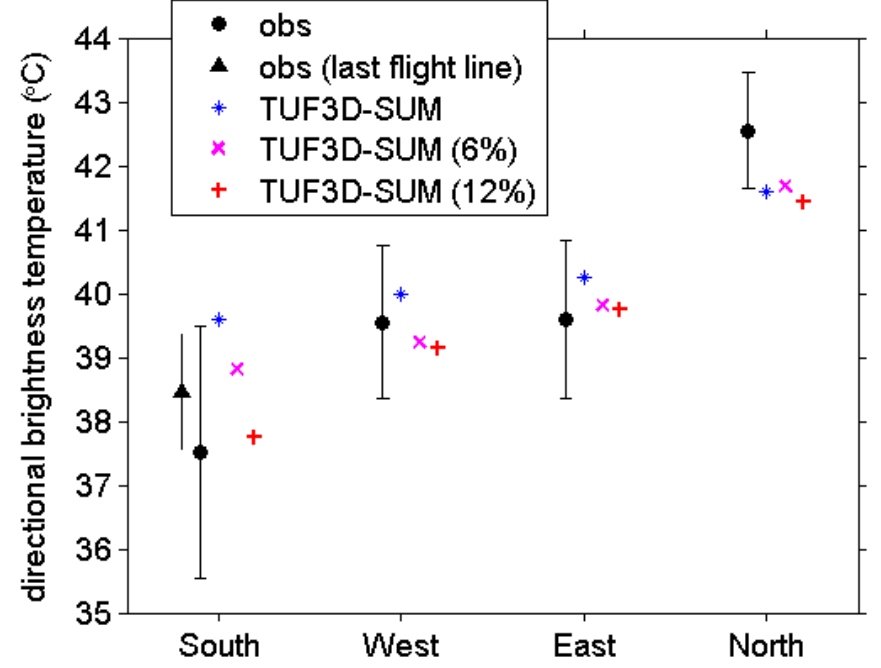
Figure 3. Directional sensor apparent (brightness) temperature of the Vancouver Light Industrial neighbourhood at ≈ 1300 LST 15 August 1992, for four view directions at an off-nadir view angle of 45°. Observed (obs) temperature median and interquartile range of all images during the flight are shown, as well as “Temperatures of Urban Facets in 3-D” (TUF3D)-Surface–sensor–sun Urban Model (SUM) temperature with and without small scale structure (6% and 12% refer to the plan area coverage of small scale structures).